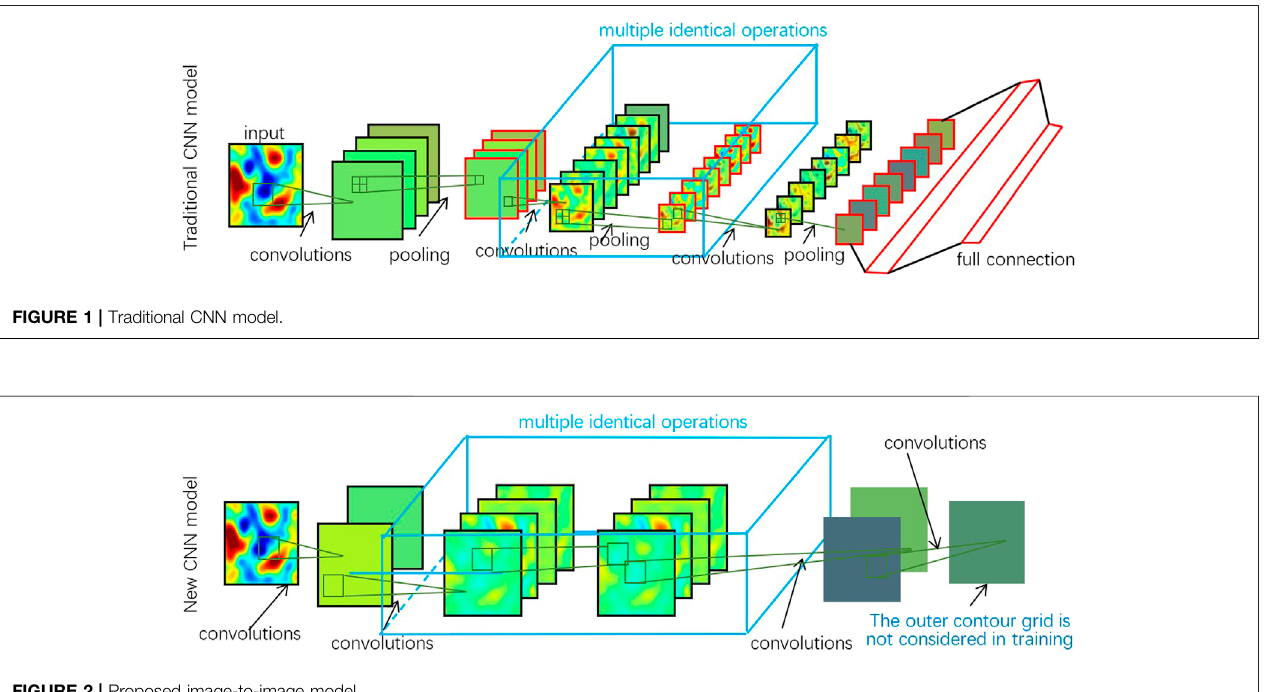
FIGURE 2 | Proposed image-to-image